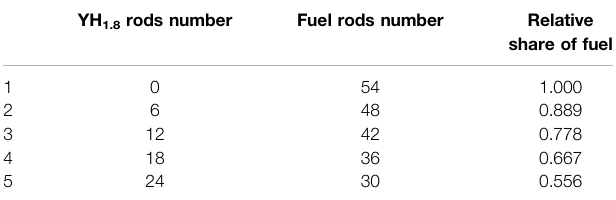
TABLE 5 | YH 1.8 solid moderator rods number setting.